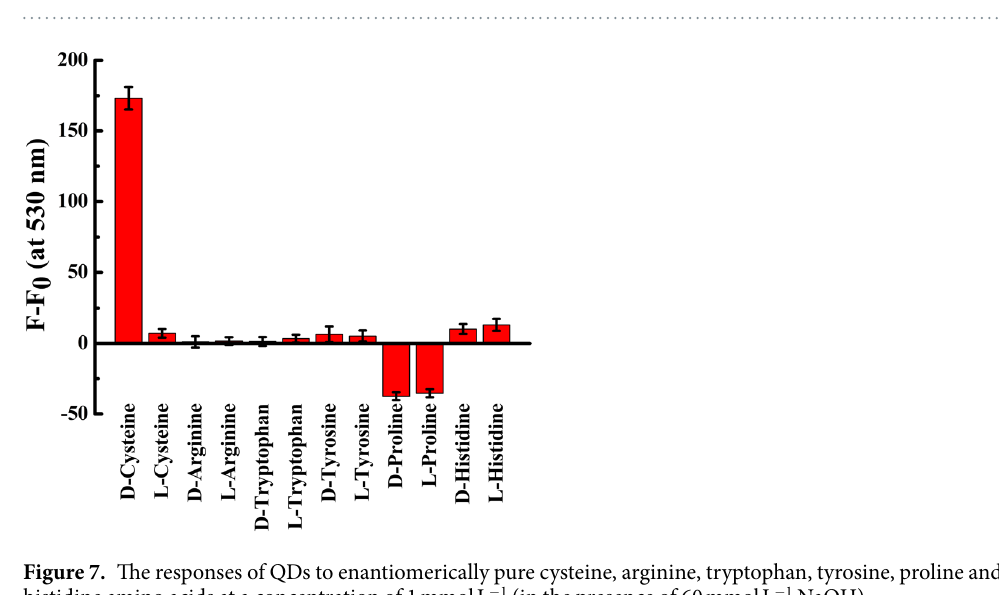
5 Scientific RepoRts | 7: 890 | DOI:10.1038/s41598-017-00983-2